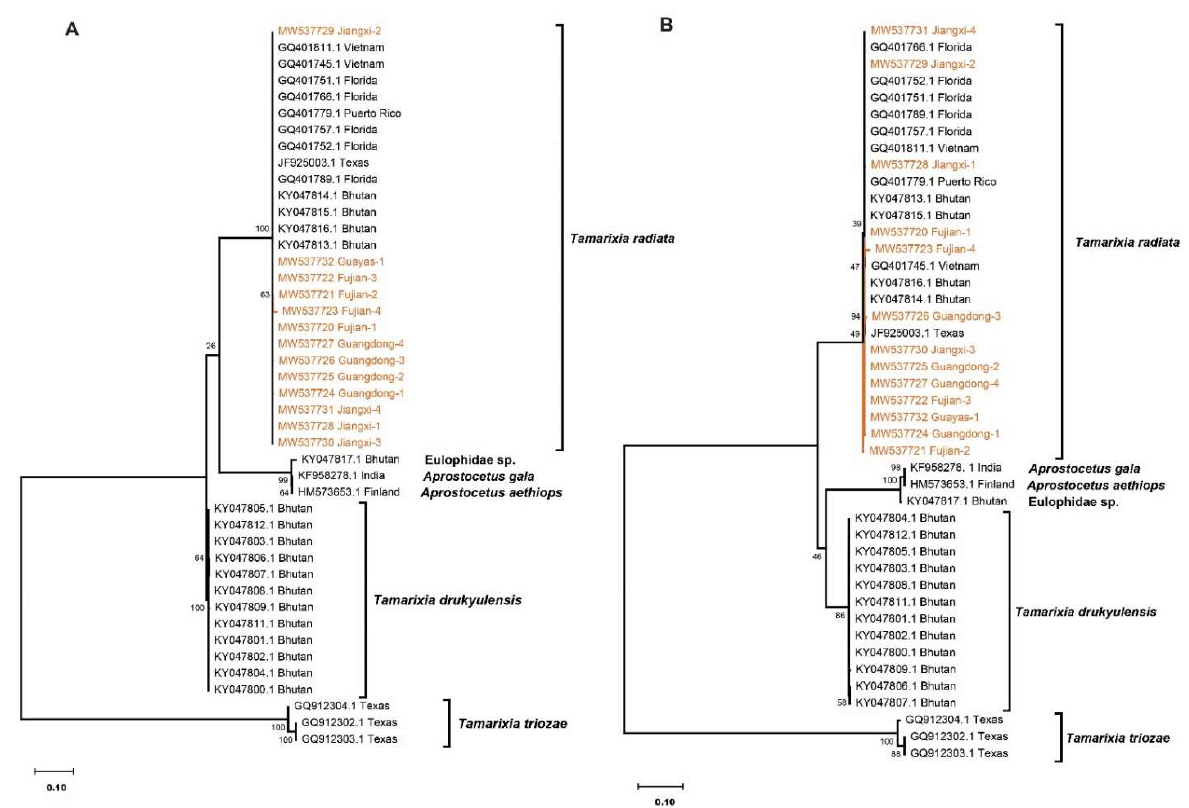
Figure 2. Phylogenetic analysis ITS2 region of Tamarixia radiata populations from different geographical locations. ( A )The phylogenetic tree was constructed through the Maximum Likelihood method through the General Time-Reversible model under maximum parsimony, and ( B ) the phylogenetic tree was constructed through the Neighbor-Joining method Maximum Composite Likelihood model. All Tamarixia radiata sequences obtained in the study are highlighted in orange lines and font.